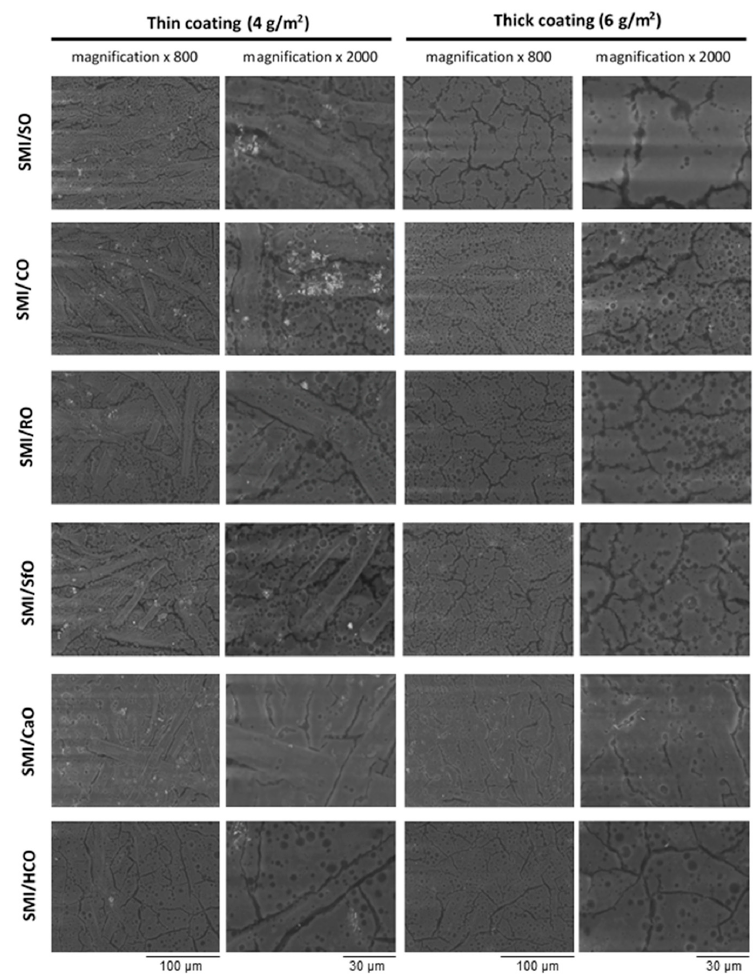
Figure 1. SEM microscopy of SMI/oil coatings on paper, including thin and thick coatings at different magnifications (indicated scale bars apply to full column).